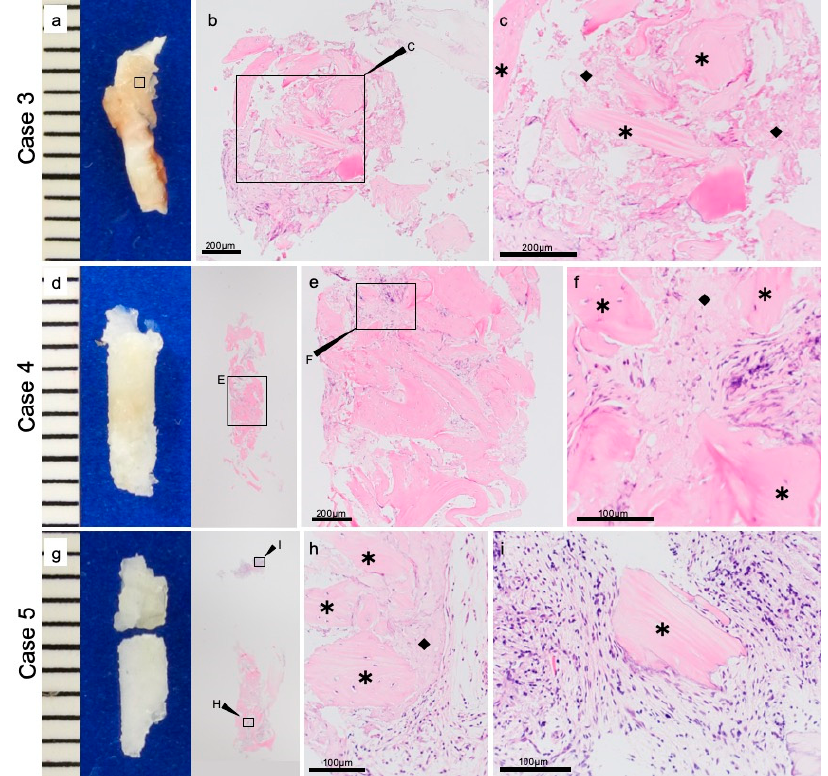
Figure 3. The fibrous tissue around the screw. Case 3: ( a ) macro findings. ( b , c ) Hematoxylin–eosin staining. Case 4: ( d ) macro findings. ( e , f ) Hematoxylin–eosin staining. Case 5: ( g ) macro findings. ( h , i ) Hematoxylin–eosin staining. In the tissue surrounding, the diamond ◆ indicate the u-HA/ PLLA screw, and the star (*) indicate the